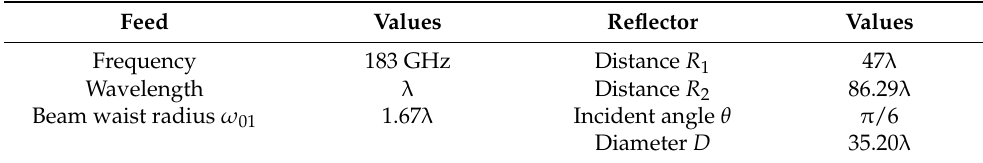
Table 1. Parameters of Feed and